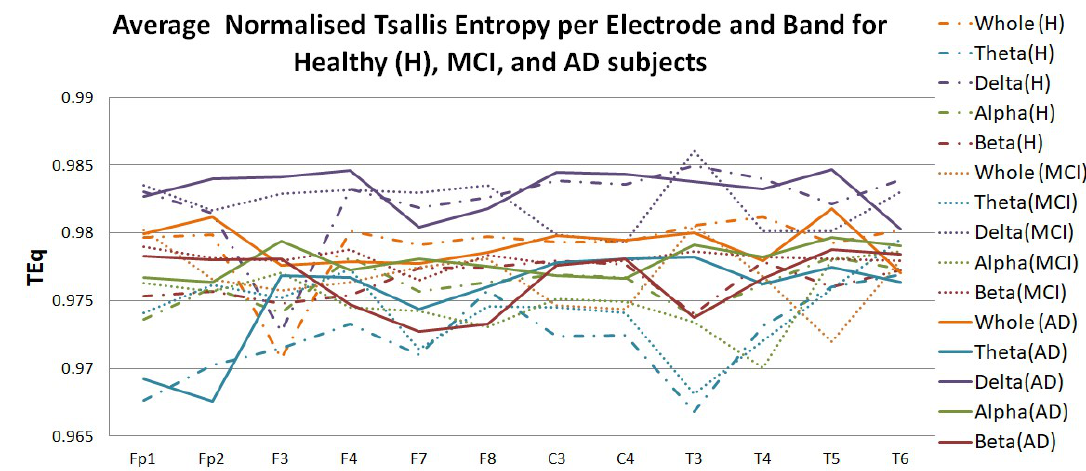
Figure A2: Average Normalised Tsallis Entropy (TE) per electrode and band for the three sample groups (1’ examined interval – closed eyes).